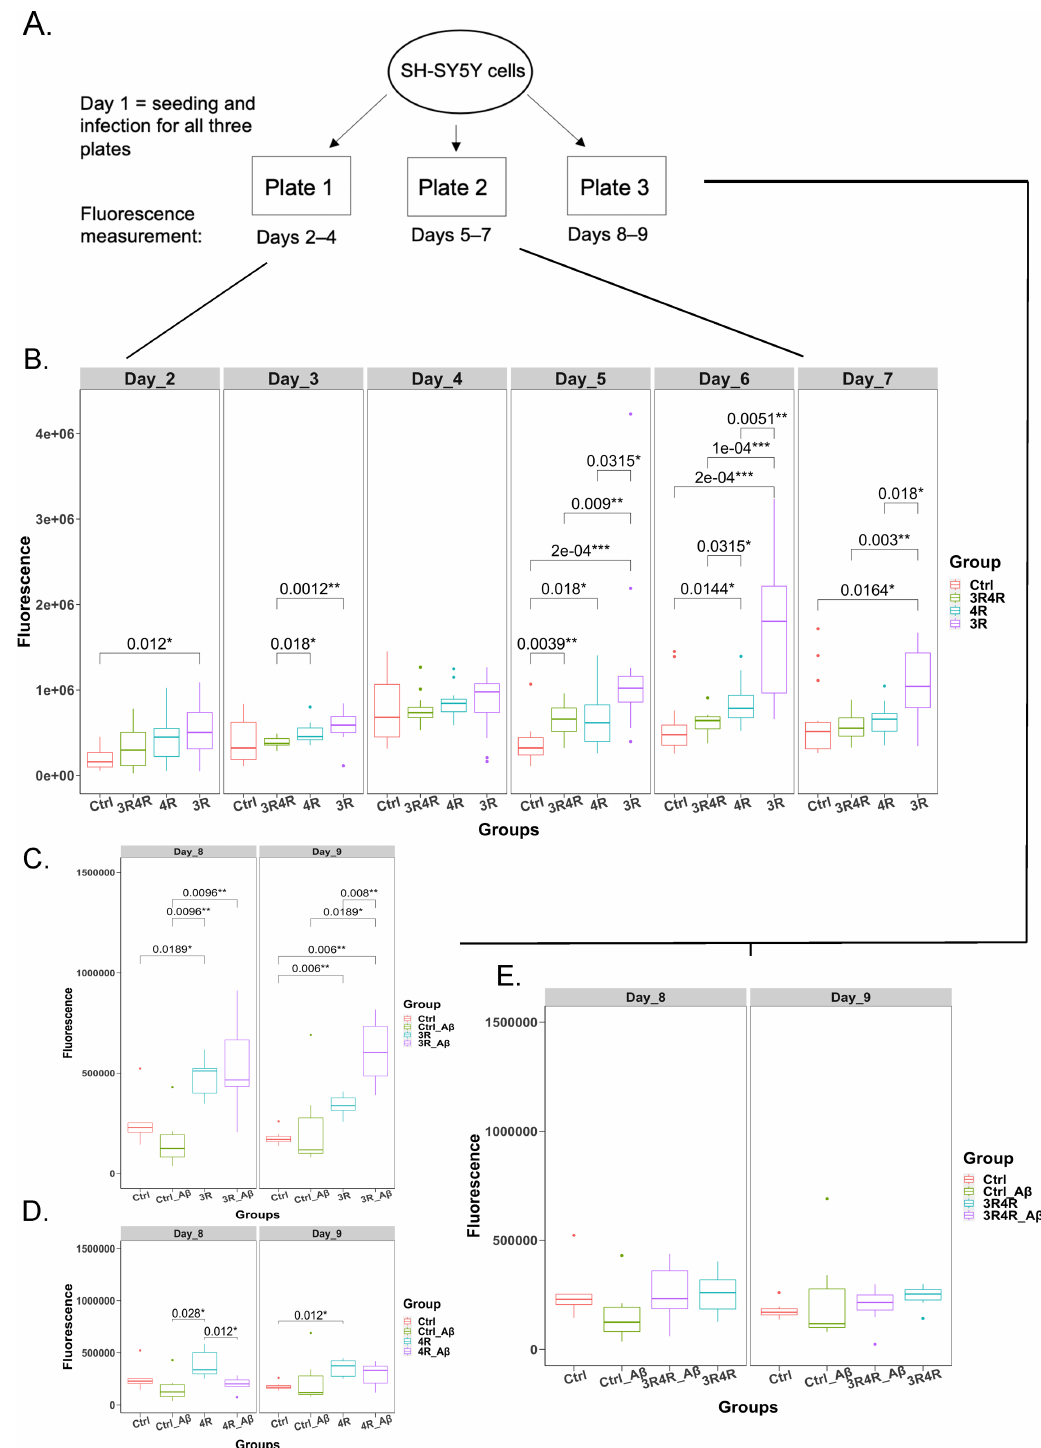
Fig 3. Cytotoxicity of tau isoforms and their interactions with A β . (A) Diagram mapping cytotoxicity assay workflow; plates 1 and 2 measured cytotoxicity through days 2–7, while plate 3 measured cytotoxicity on days 8–9, which captured cytotoxicity changes as a function of A β treatment. (B) Comparison of fluorescence values (cytotoxicity proxy, with higher fluorescence signifying greater levels of cell death) over days 2–7 for LV-Ctrl, LV-3R4Rtau, LV-4Rtau, and LV-3Rtau groups. (C) Comparison of fluorescence/cytotoxicity between LV-Ctrl treated with DMSO, LV-Ctrl treated with A β , LV-3Rtau treated with A β and LV-